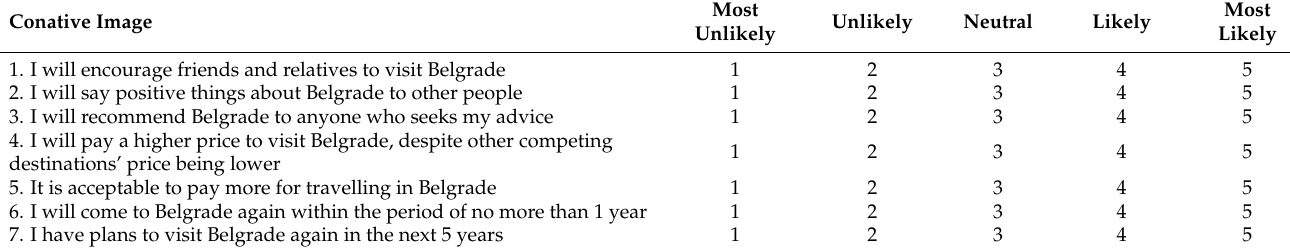
Table A3. Items for conative image.